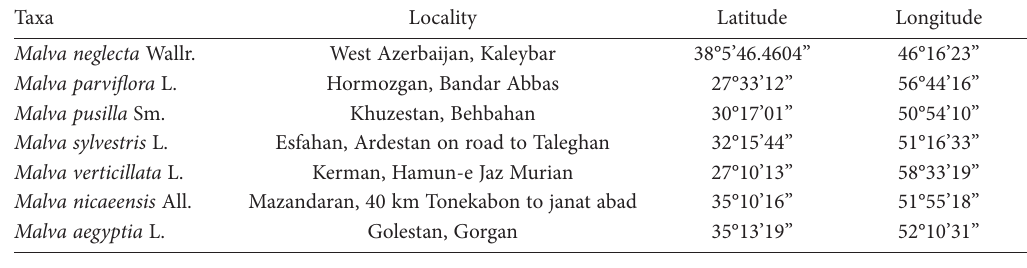
Table 1. List of the investigated taxa including origin of voucher specimens.